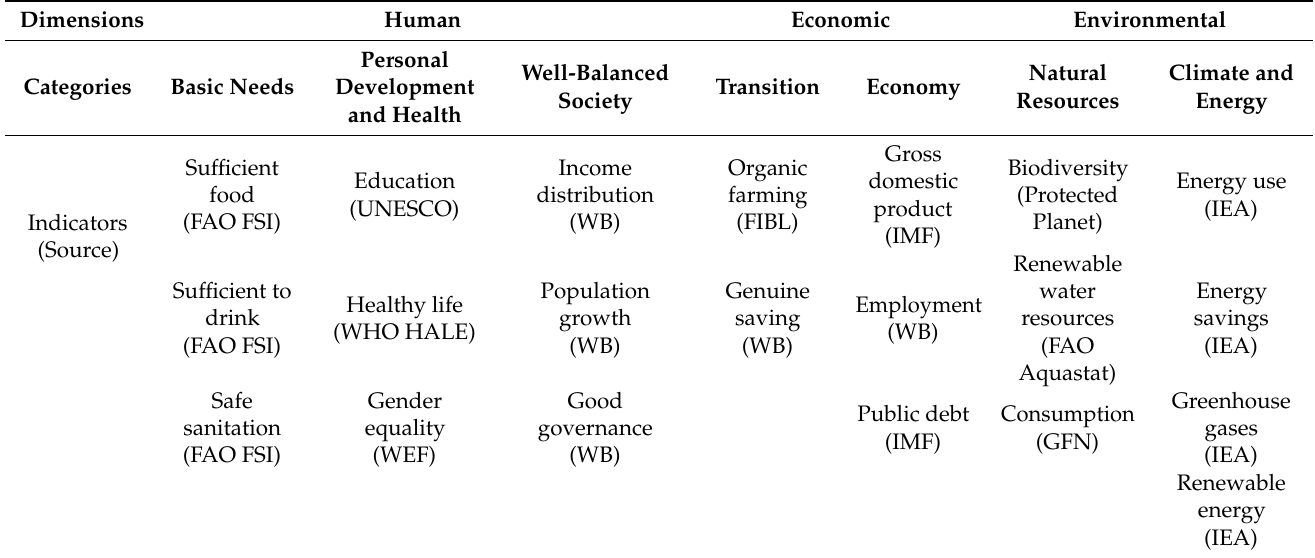
Table 4. The SSI